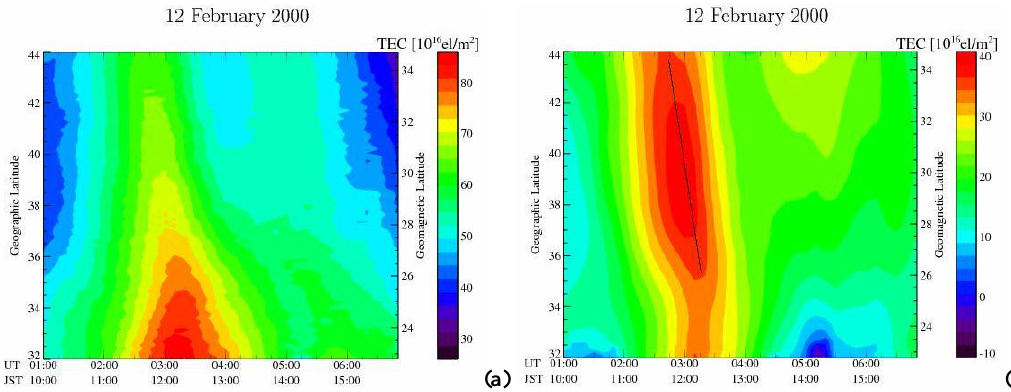
Fig. 2. The contours for latitudinal and temporal variations of (a) TEC, and (b) TEC enhancements on 12 February 2000 compared to quiet-time (reference) values. The line drawn in this figure indicates the southward trend of propagation of TEC enhancements compared to quiet-time (reference)